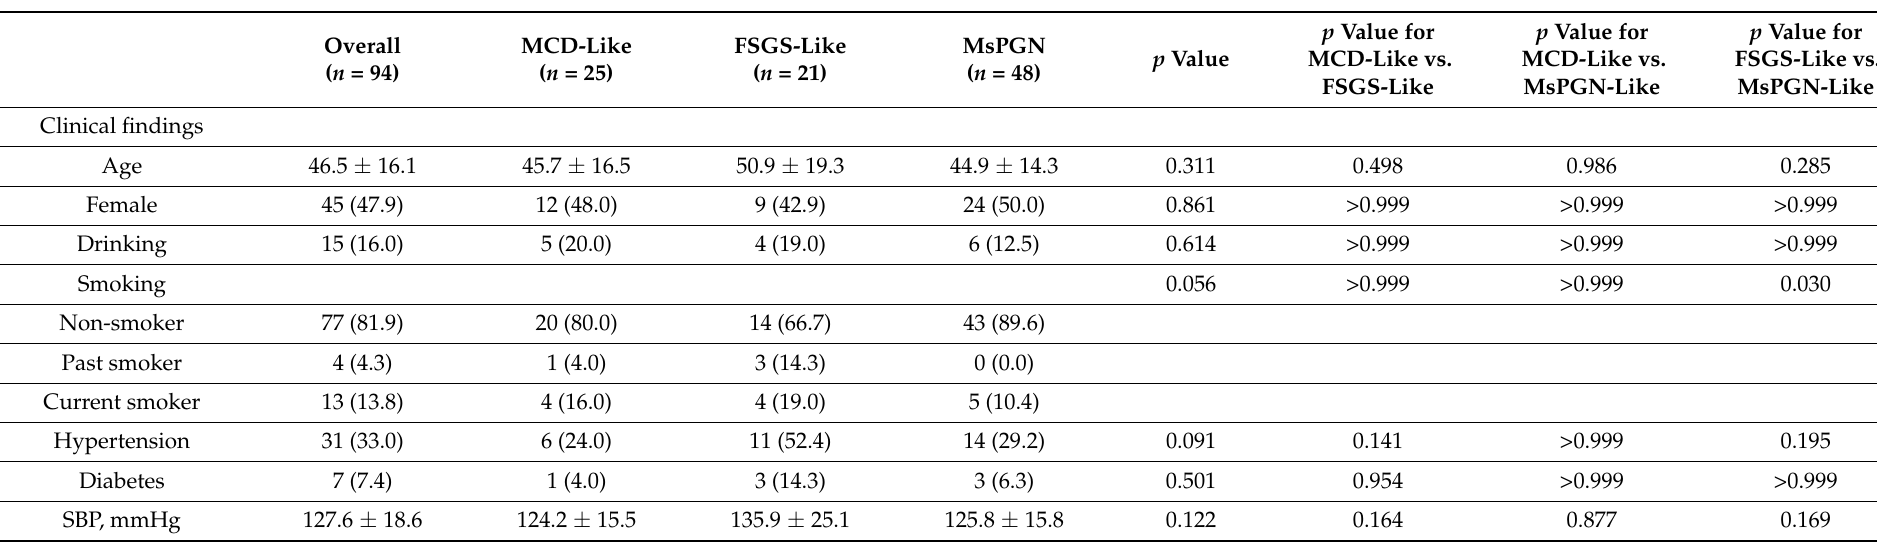
Table 4. Clinical and pathological comparisons among IgMN subtypes according to light microscopic